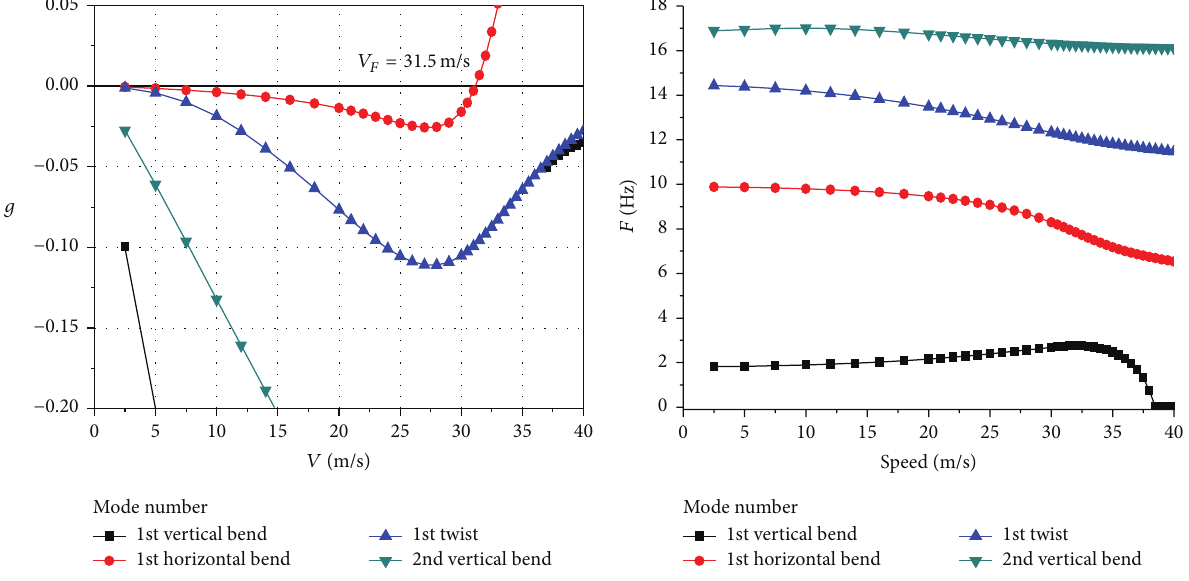
Figure 20: 𝑉 - 𝑔 and 𝑉 - 𝐹 curves under 31.5